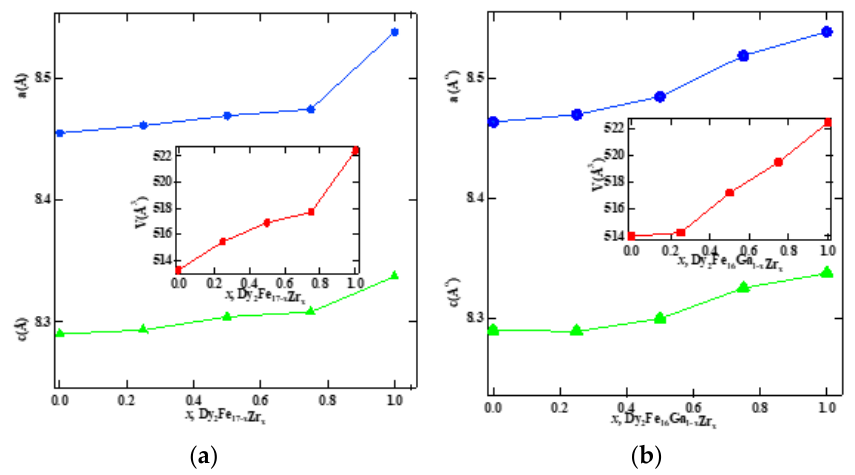
Figure 1. Rietveld refinement profile for ( a ) Dy 2 Fe 17 , ( b ) Dy 2 Fe 16.5 Zr 0.5 , ( c ) Dy 2 Fe 16.25 Zr 0.75 and ( d ) Dy 2 Fe 16 Ga 0. Zr 0.25 .